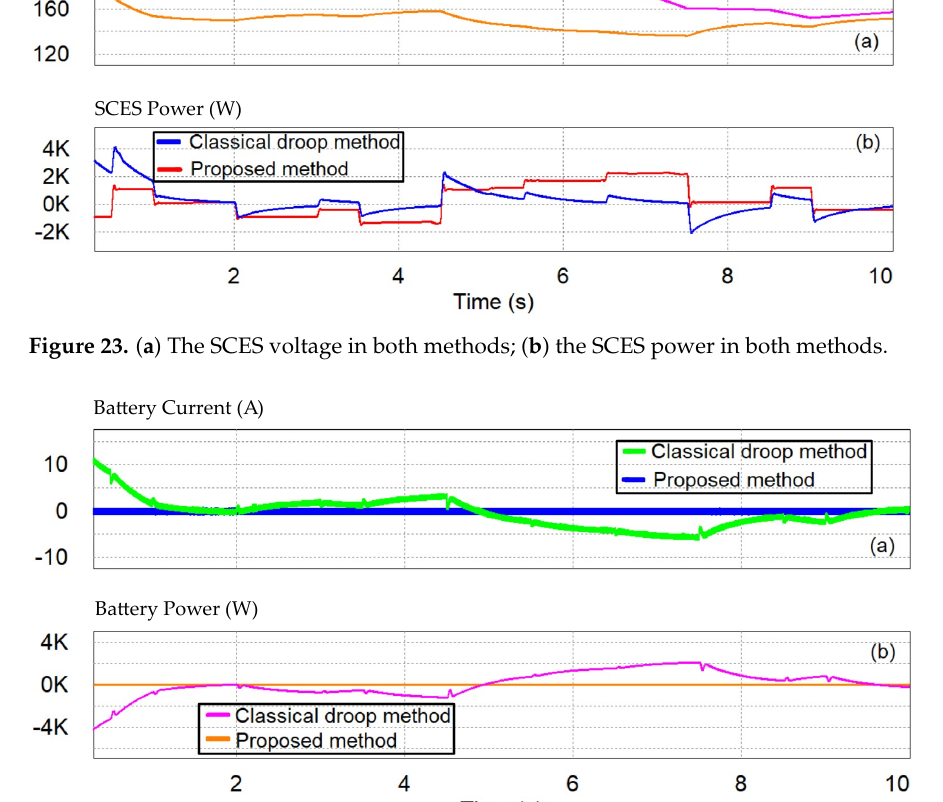
Figure 24. ( a ) The battery current; ( b ) the battery power.